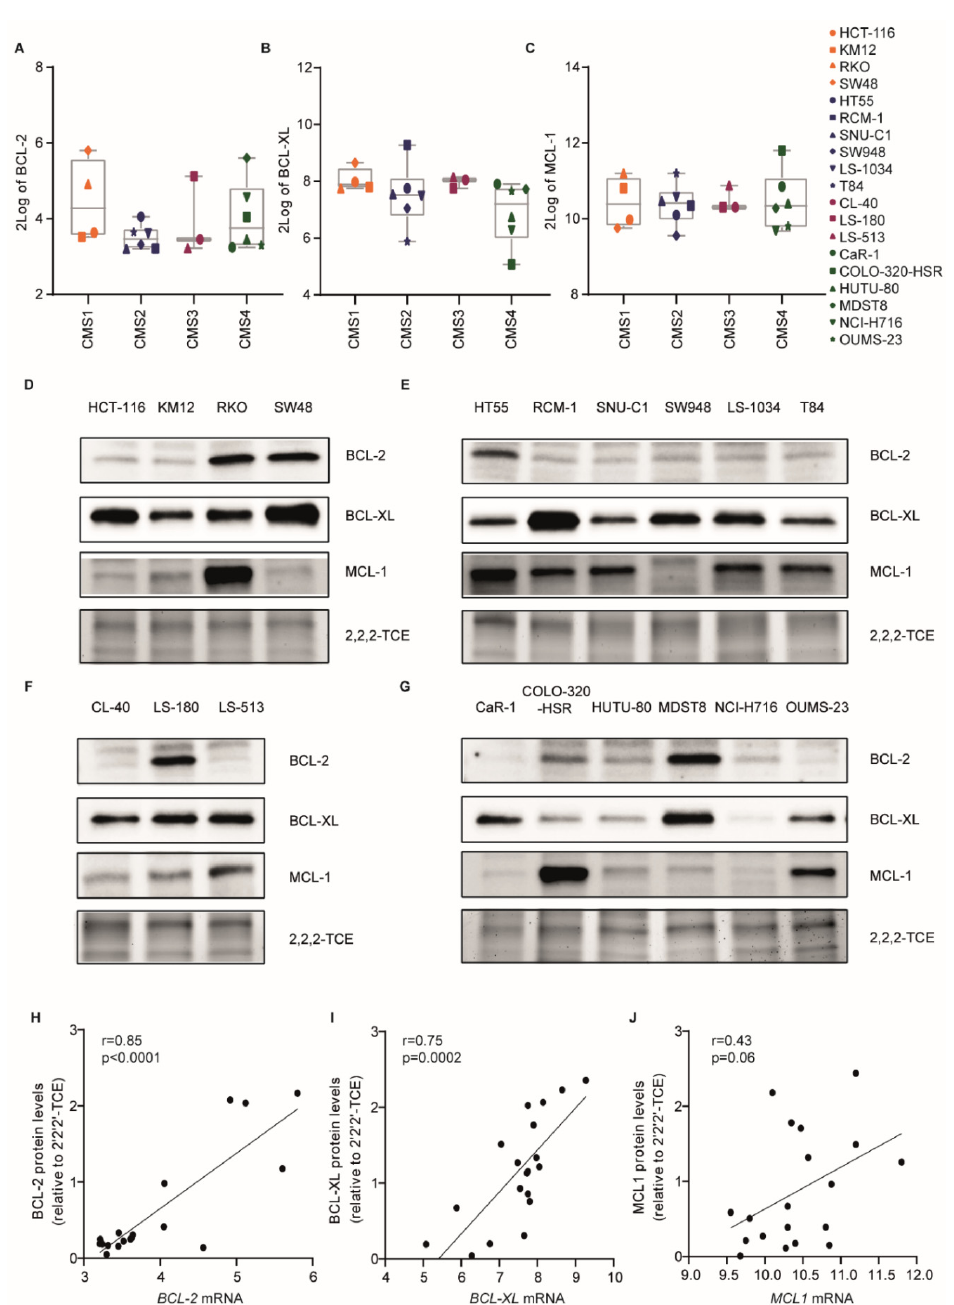
Figure 3. The mRNA and protein expression of BCL-2 family members in CRC cell lines. ( A – C ) 2Log expression of BCL-2 ( A ), BCL-XL ( B ), and MCL1 ( C ) mRNA in the CRC cell line panel grouped according to their CMS subtype. The legend indicates the symbols assigned for each cell line. ( D – G ) Western blot analysis for BCL-2, BCL-XL, and MCL-1 expression in CMS1 ( D ), CMS2 ( E ), CMS3 ( F ), and CMS4 ( G ) cell lines. 2,2,2-Trichloroethanol (2,2,2-TCE) signal (excerpt taken around 40 kDa region) indicates the amount of protein loaded per cell line. ( H – J ) Correlation between RNA (as in panel A – C ) and protein (as in panel D – G ) levels of BCL-2 ( H ), BCL-XL ( I ), and MCL-1 ( J ) in the cell line panel. N = 19. Pearson’s correlation (two-tailed p -value).